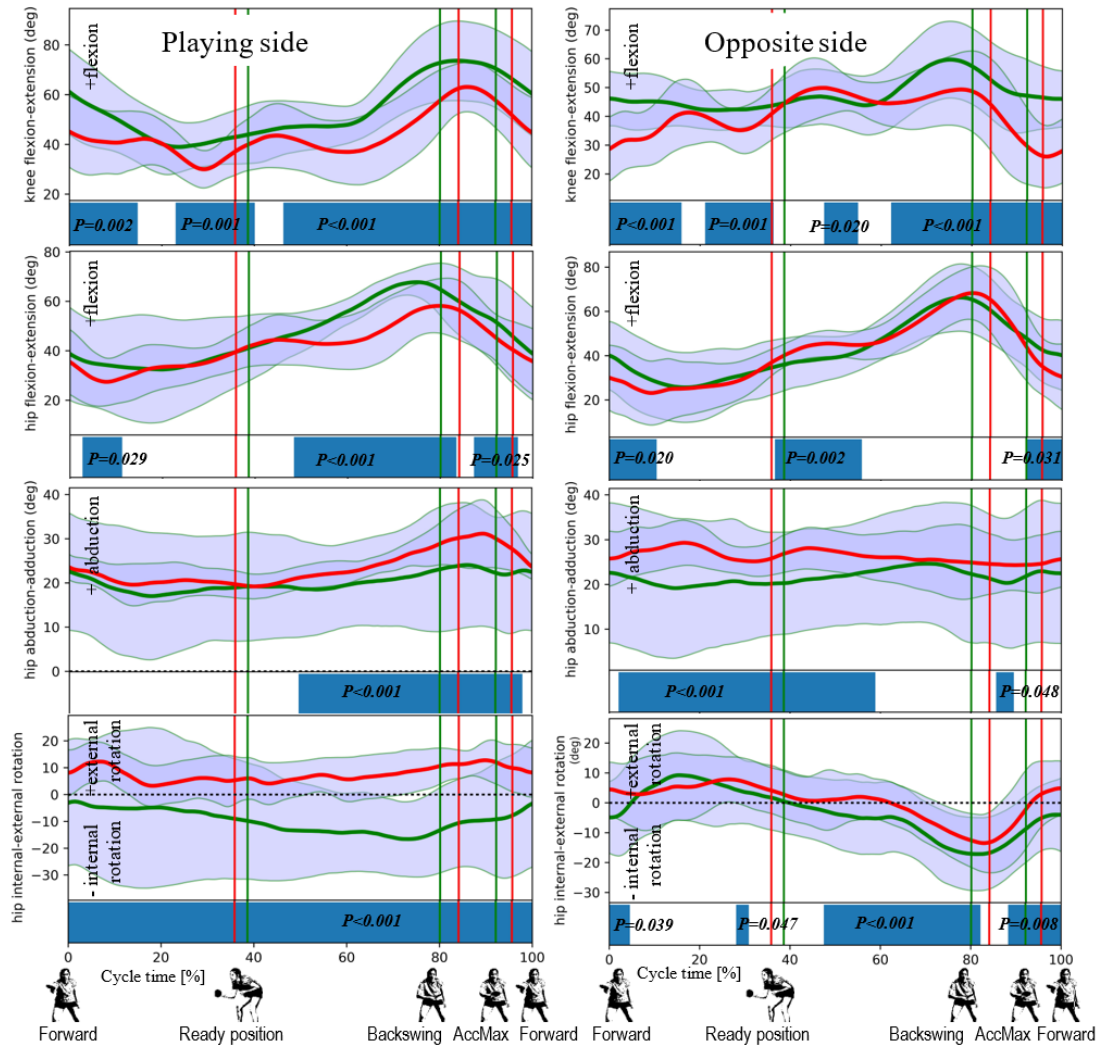
Figure 4. Differences in low-extremity angular kinematics between female (in red) and male (in green) players revealed by the SPM for knee flexion-extension, hip flexion-extension, hip abduction-adduction, and hip internal-external rotation for the playing side ( left column ) and opposite/contralateral side ( right column ). The statistically significant differences (for p < 0.05) are marked on the horizontal bar.